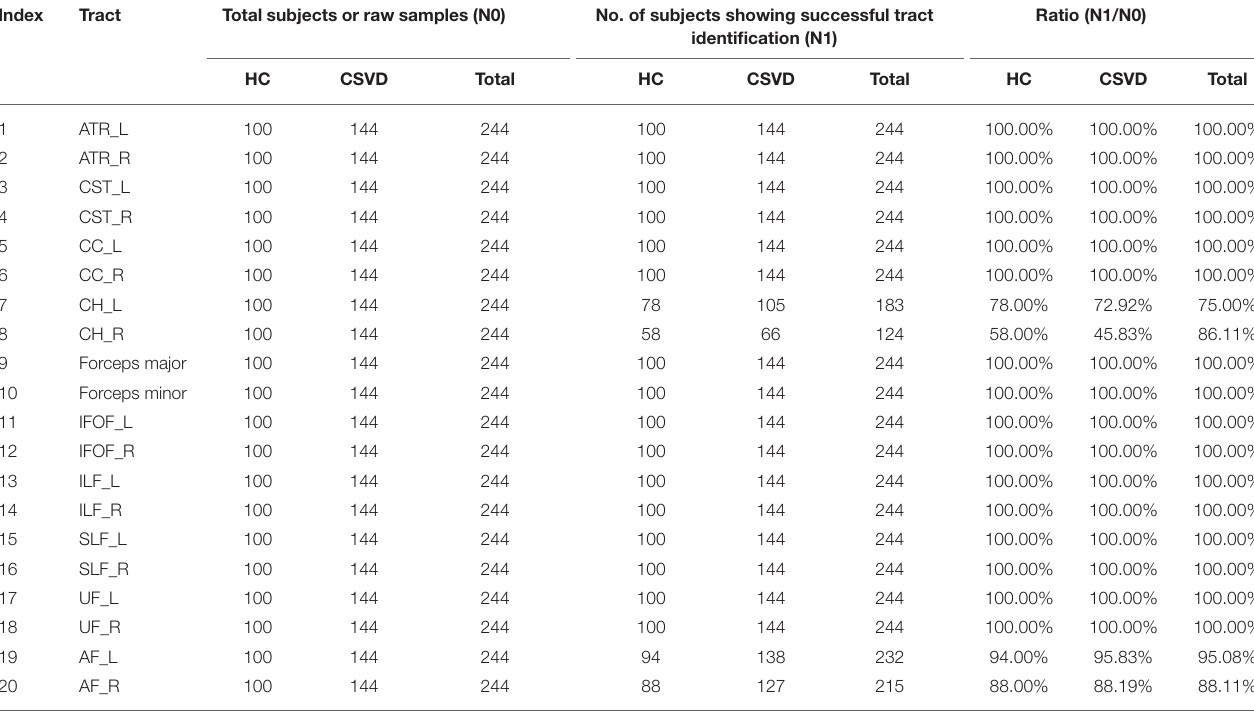
TABLE 1 | Successful identification rate for each of 20 fiber tracts in HC and CSVD